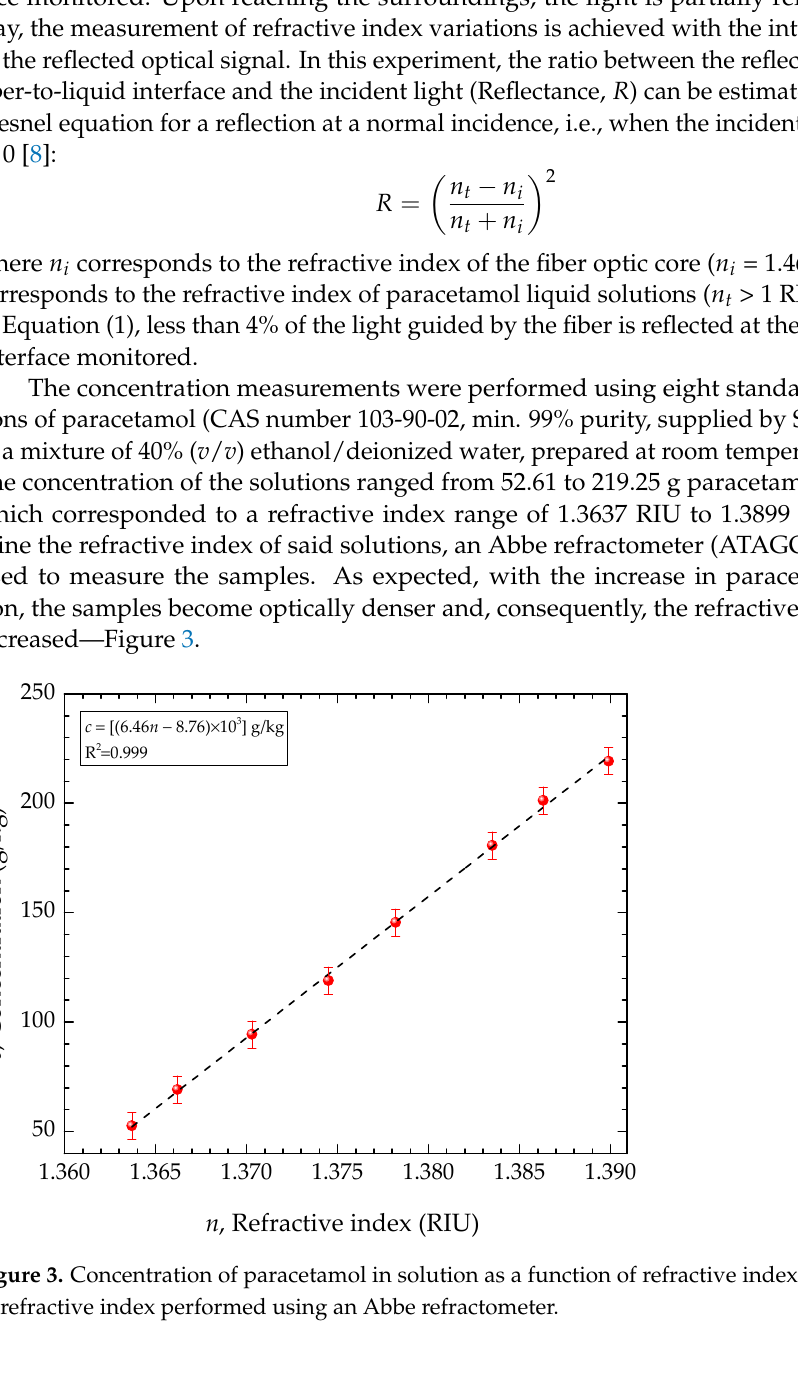
Figure 3. Concentration of paracetamol in solution as a function of refractive index. Measurements of refractive index performed using an Abbe refractometer. 1.360